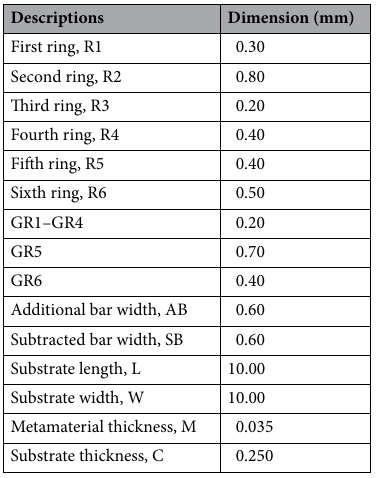
Table 1. Description of proposed MSM unit cell metamaterial. GR gap between